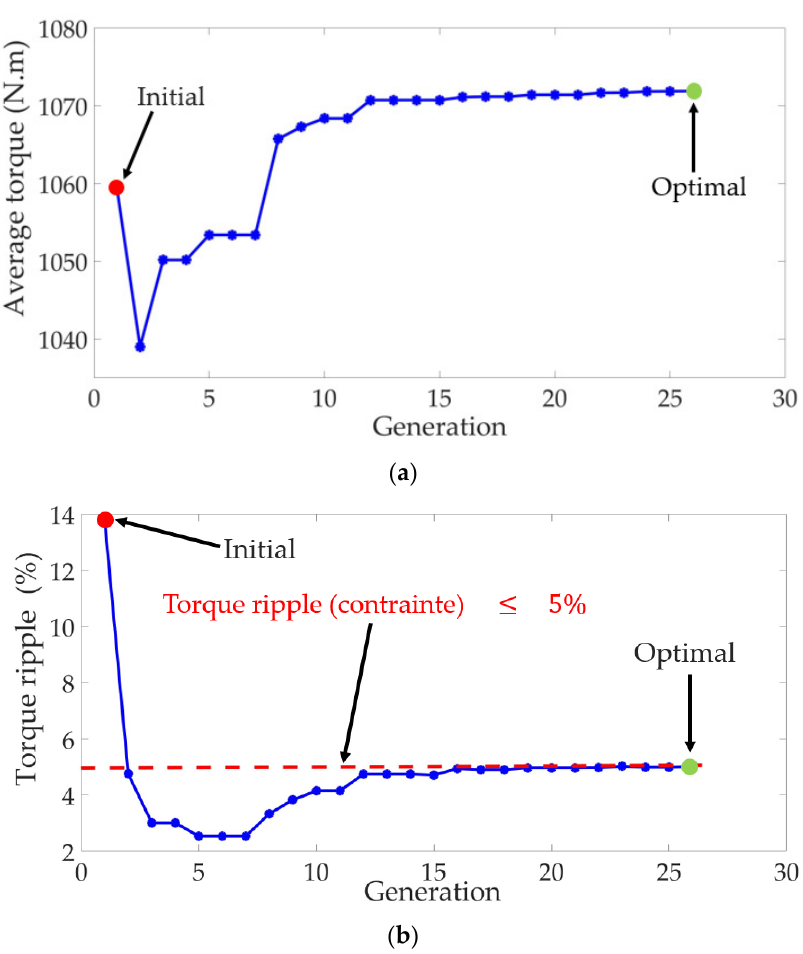
Figure 22. Optimization history. ( a ) Evolution of the average torque over generations. ( b ) Evolution of the torque ripple over generations.